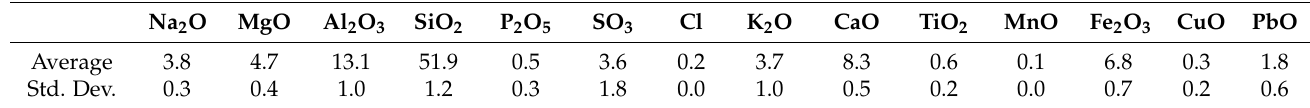
Table 7. SEM/EDX results in wt% for the studied bodies of the technical ceramic ( N =